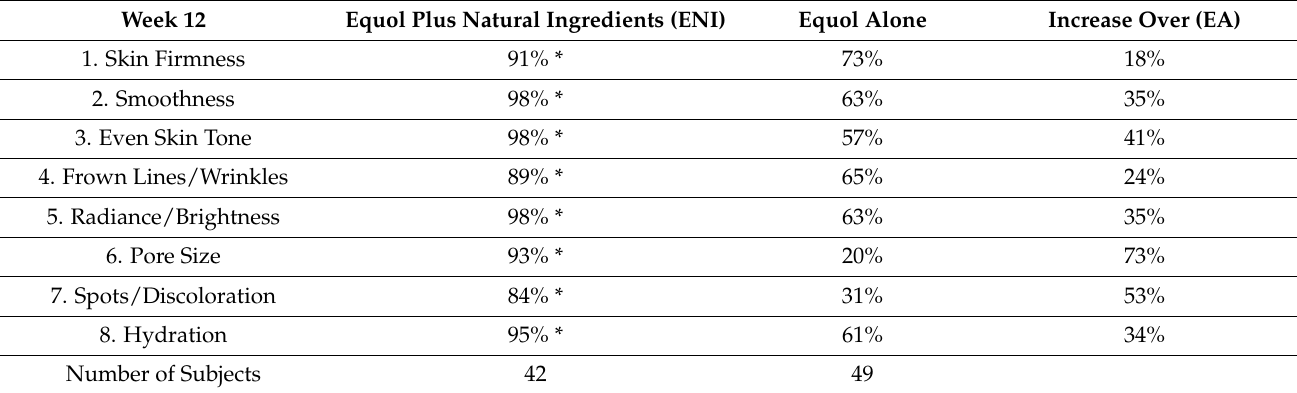
Table 2. Self-Assessment Questionnaire Analysis—Facial Features [160] Efficacy: percentage of subjects that perceived improvement with the equol plus natural ingredients (ENI) over the baseline (parameters 1–8 data not shown) and/or compared to the equol treatment alone (EA) at 12 weeks (see